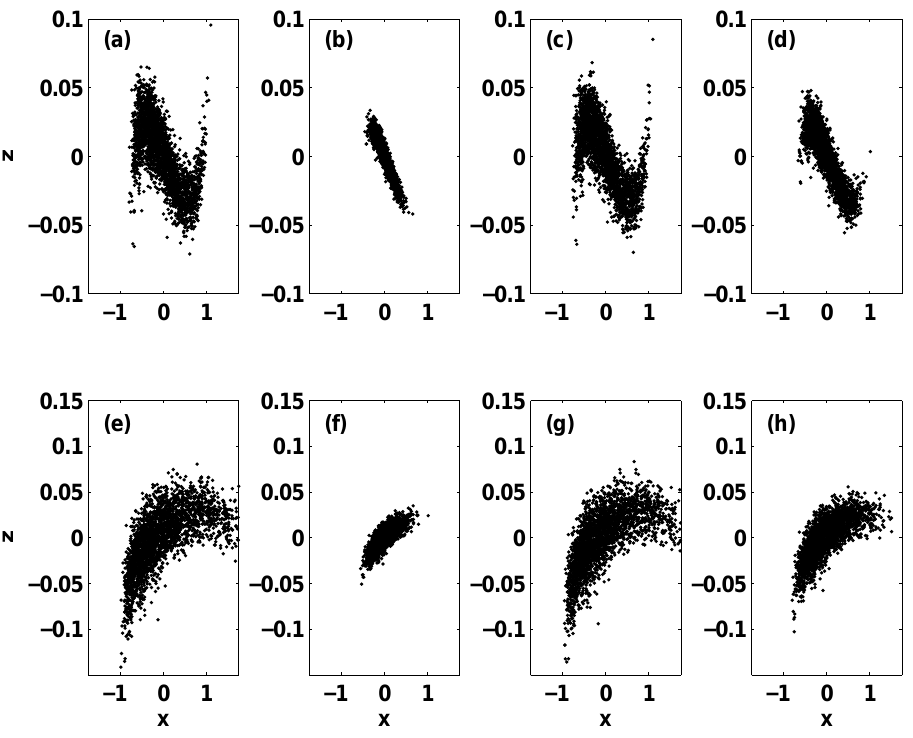
Fig. 7. The effect of changes in noise parameters on the particle clouds. t = 49 . 2 (a–d) , t = 65 . 6 (e–h) . (a, e) Control case, (b, f) tenfold increase in correlation time, tenfold decrease of standard deviation, (c, g) tenfold increase in correlation time, 80% reduction of standard deviation, (d, g) one hundredfold increase in correlation time, tenfold decrease in standard